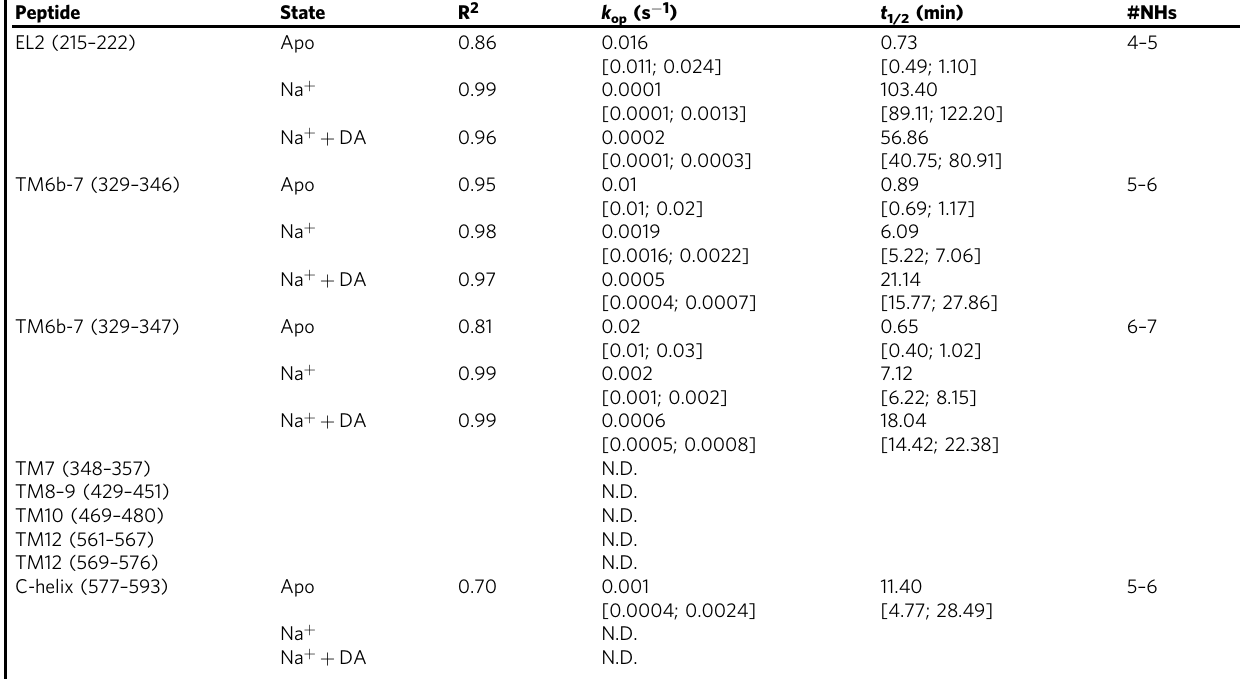
Table 1 Kinetic parameters for dDAT regions showing EX1 or EXX kinetics Peptide State R